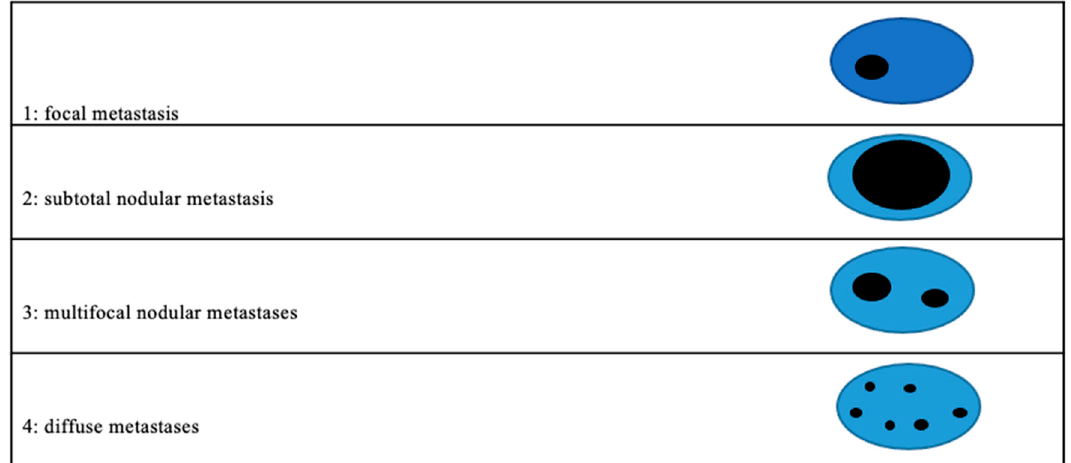
Figure 2. Pattern of metastases distribution in the lymph nodes.